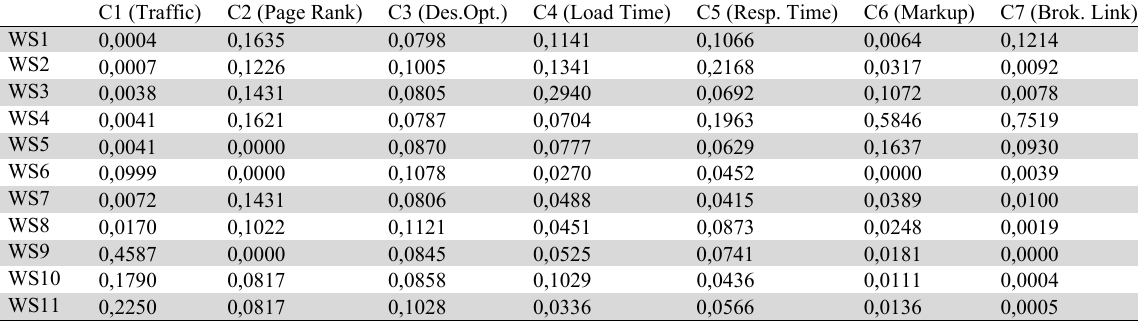
Normalized Decision